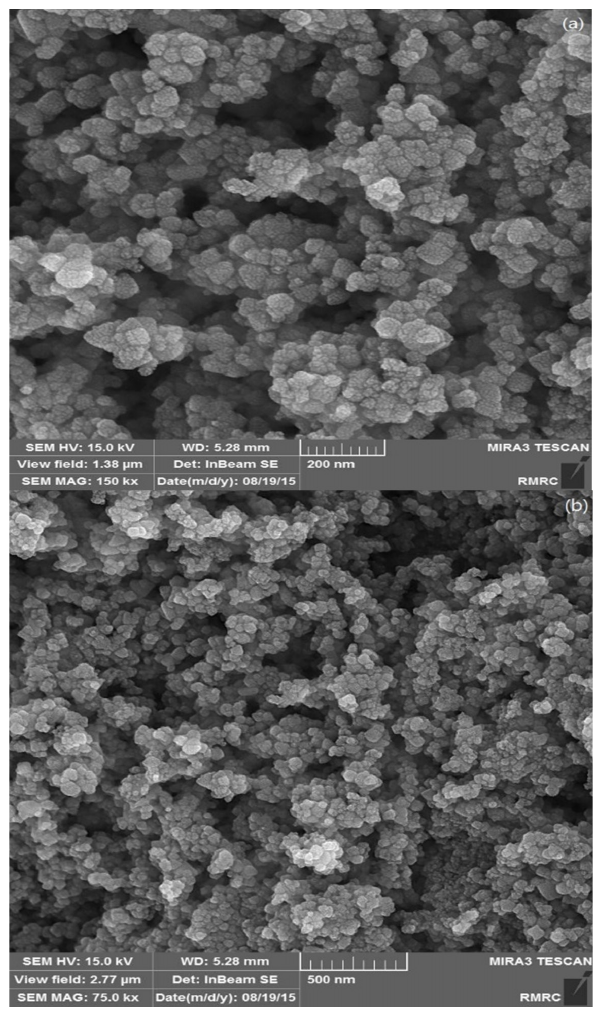
Fig.6. FESEM image of magnetite nanoparticles sample 1 in the scale of a) 200 nm, b) 500 nm.